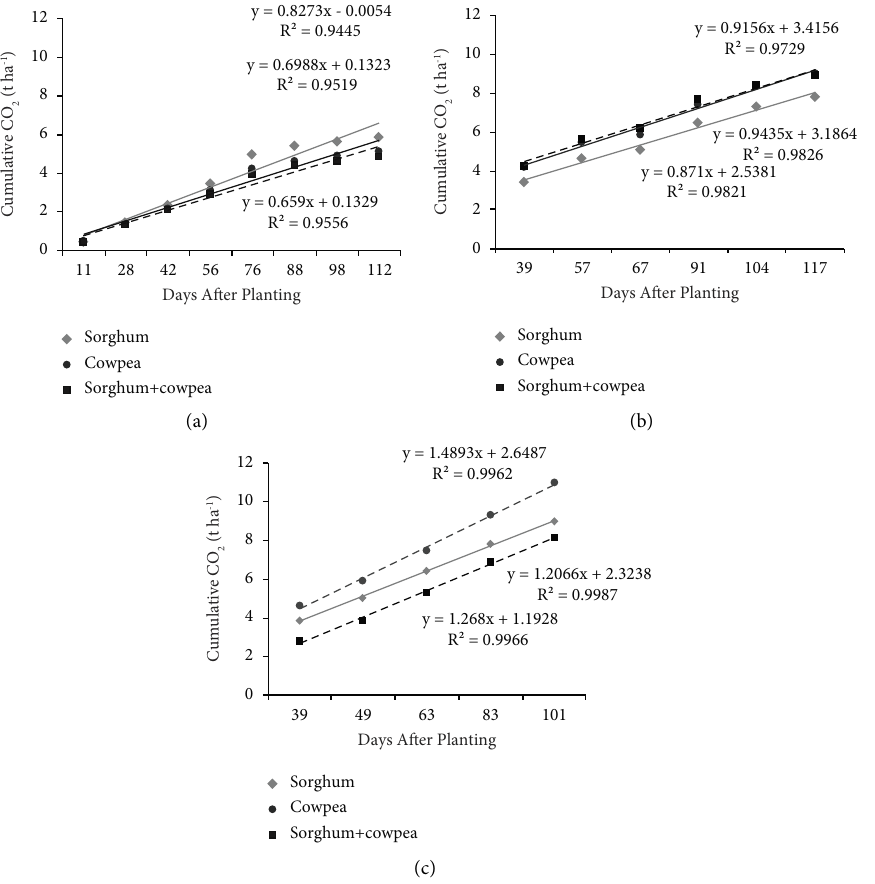
Figure 15: Cumulative CO 2 emissions of sorghum and cowpea in sole, sorghum, and cowpea in intercrop at Syferkuil during 2018/19 (a) and 2020/21 (b) as well as Ofcolaco in 2020/21